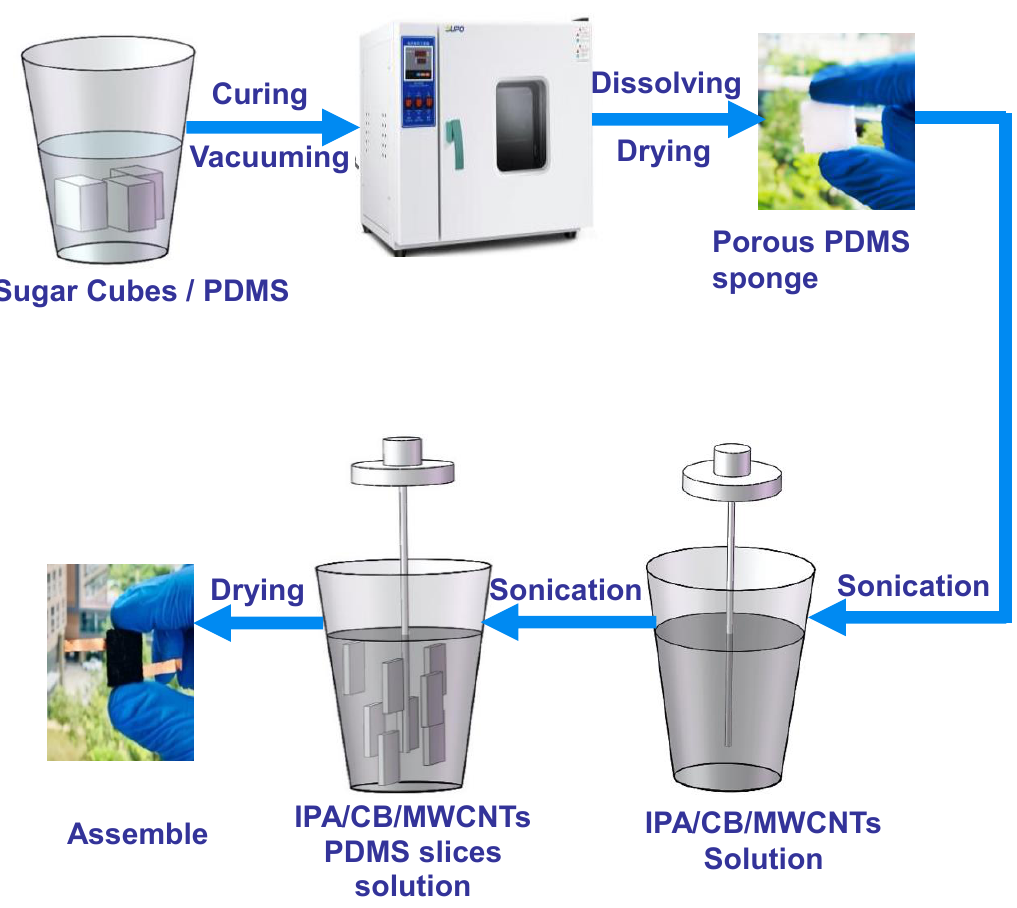
Figure 1. Schematic diagram of the fabrication process of the flexible piezoresistive tactile sensor based on 3D microstructure with carbon black (CB) / multiwalled carbon nanotube (MWCNT) conductive network. PDMS = polydimethysiloxane.